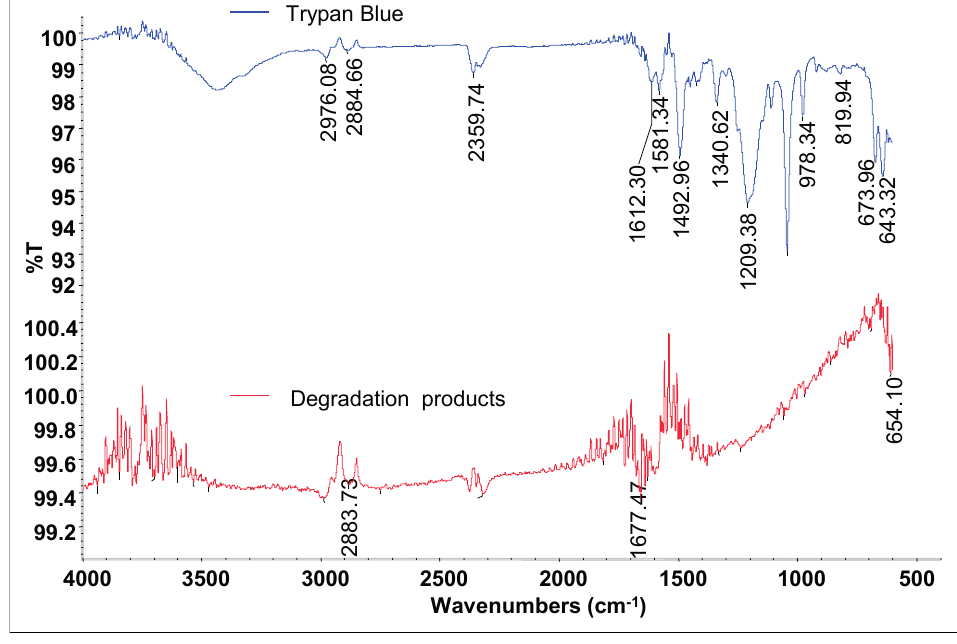
Figure 7. FTIR analysis of a Trypan Blue control and its degradation products obtained after 24 h treatment with the microbial